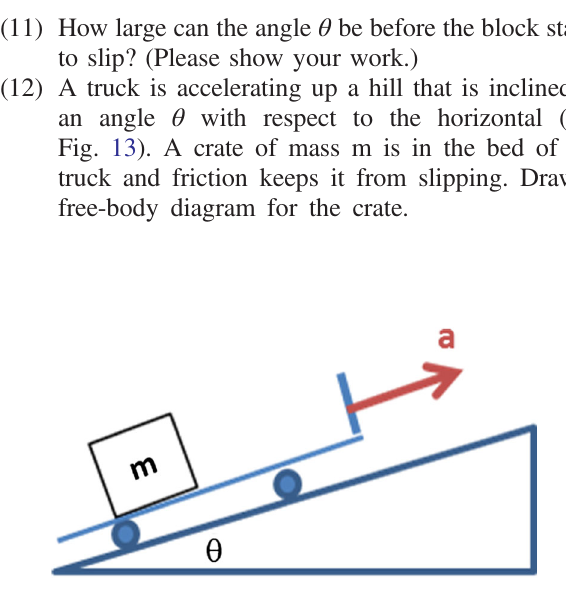
FIG. 13. Figure for friction post-test problem 12.